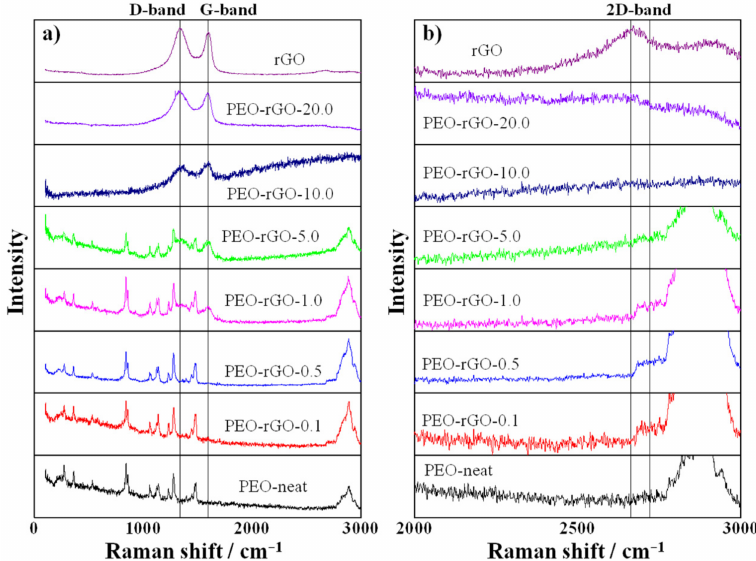
Figure 6. ( a ) Raman spectra of rGO, electrospun PEO-neat and electrospun PEO-based samples modified with rGO. ( b ) Zoomed spectral region to better visualize the appearance of the 2D